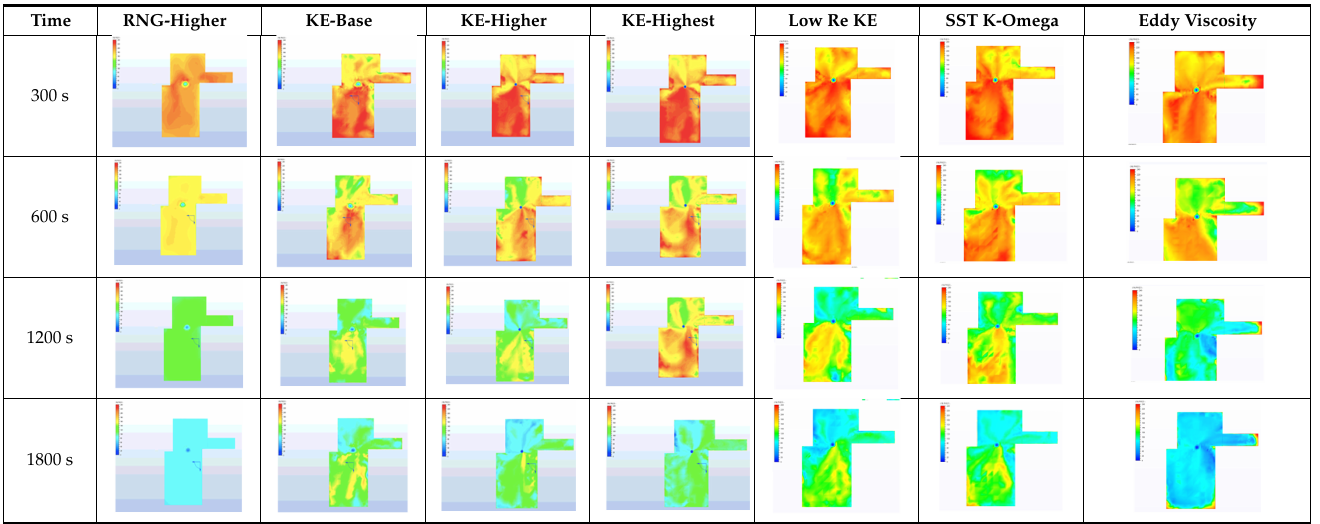
Table 2. Results of the simulation with different models.